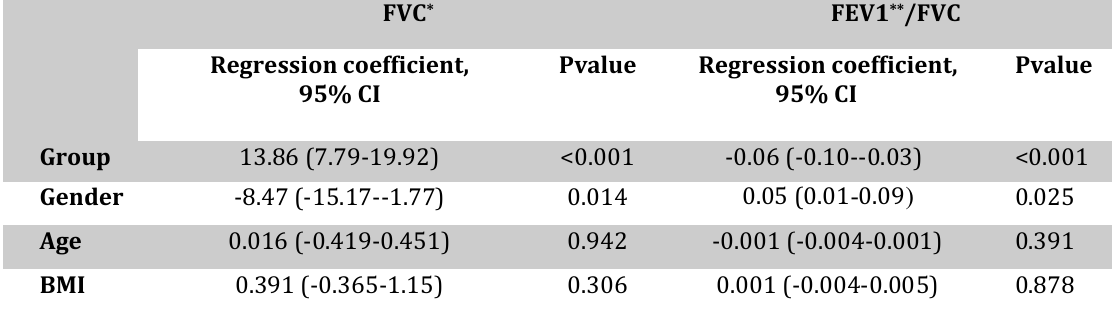
Table 3. Effect of diabetes on FVC and